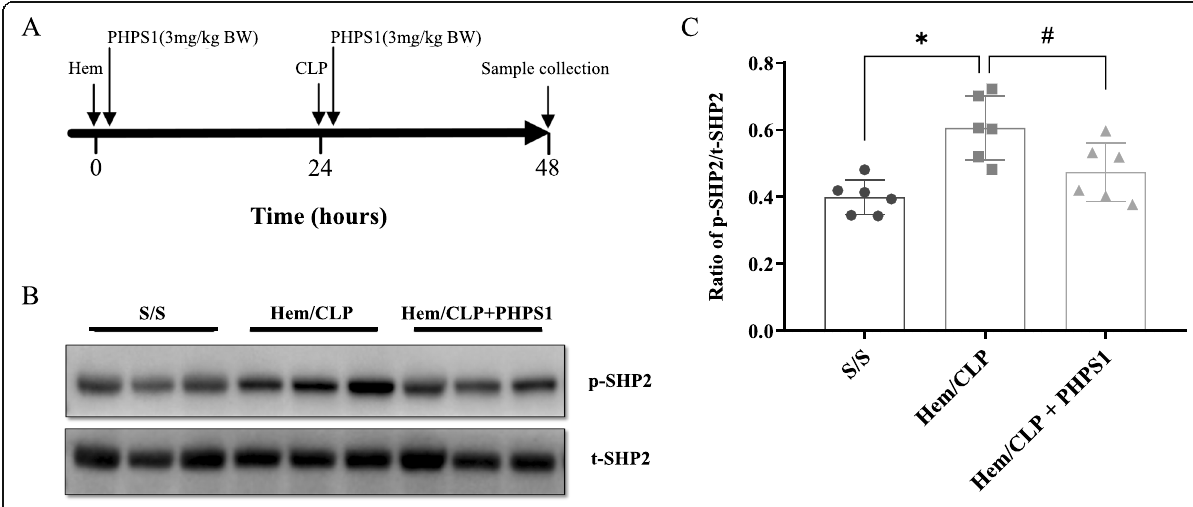
Fig. 1 SHP2 activation in the kidney is reduced by PHPS1 treatment. Diagram of experimental timeline for PHPS1 (3 mg/kg BW) administration, Hem, CLP and mice sacrifice ( a ). Twenty four h post-Hem/CLP or Sham operation, the kidneys were collected and tissue homogenates were obtained. The extent of SHP2 activation (phosphorylation) was determined by western blot ( b , c ). The ratio of phosphorylated SHP2 and total SHP2 (p-SHP2/t-SHP2) in kidneys from Hem/CLP mice was significantly increased compared to Shams. PHPS1 treated Hem/CLP mice showed reduced SHP2 activation compared to Veh treated Hem/CLP mice. *, P < 0.05, versus Sham (S/S); #, P < 0.05, PHPS1 treated group (Hem/CLP + PHPS1) versus Hem/CLP+ vehicle (Hem/CLP). One-way ANOVA and a Student-Newman-Keuls ’ test, Mean ± SD; n = 6 mice/group